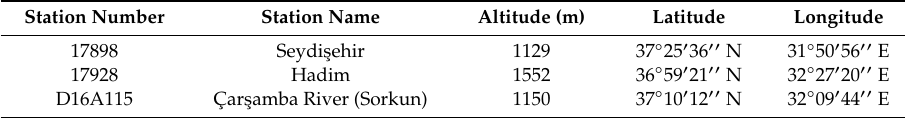
Table 3. The meteorology and streamflow observation stations used in this